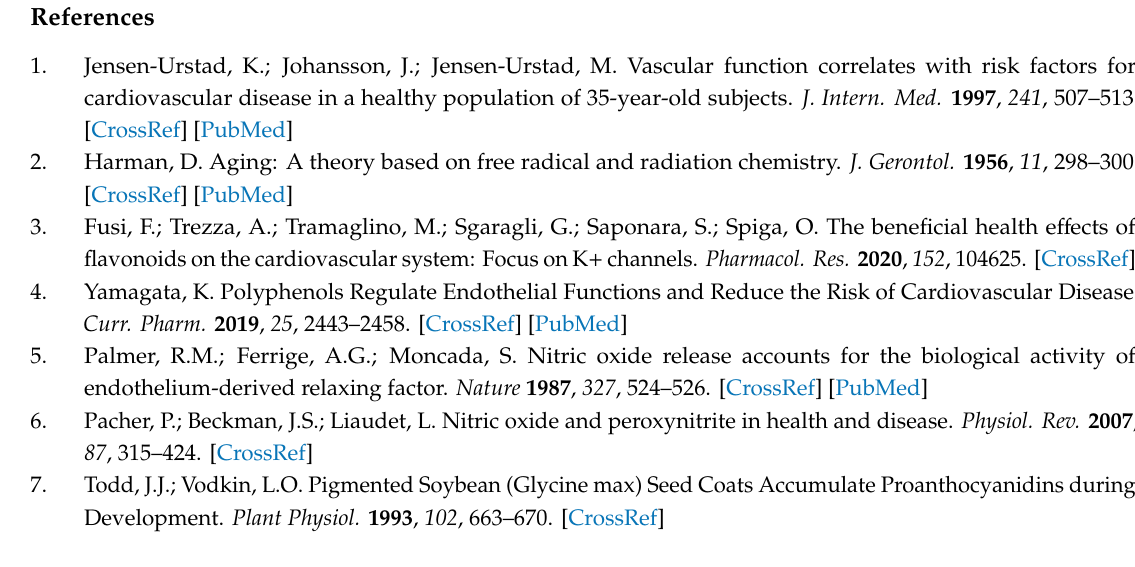
Table S1: Supporting data for anthropometric parameters of participants during the 4-week trial (Table 3); Table S2: Supporting data for the e ff ect of black soybean consumption on the vascular function (Table 4); Table S3: Supporting data for the e ff ect of black soybean consumption on the antioxidant activity (Table 5); Table S4: Supporting data for the e ff ect of black soybean consumption on polyphenol concentration in the plasma (Figure 1); Table S5A: Supporting data for the e ff ect of black soybean consumption on polyphenol concentration in the urine (Figure 2); Table S5B: Supporting data for the e ff ect of black soybean consumption on polyphenol concentration in the urine (Figure